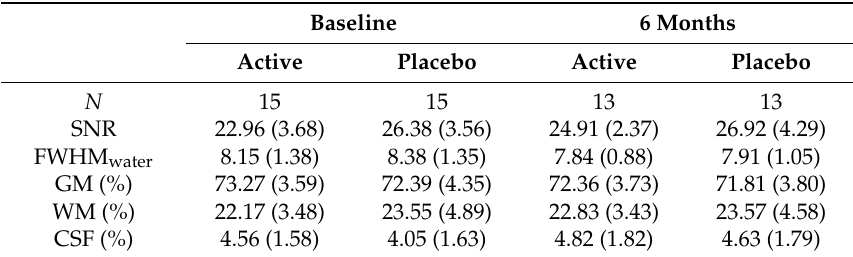
Table 3. Means and standard deviations for 1H-MRS fit statistics of the posterior cingulate cortex voxel data between